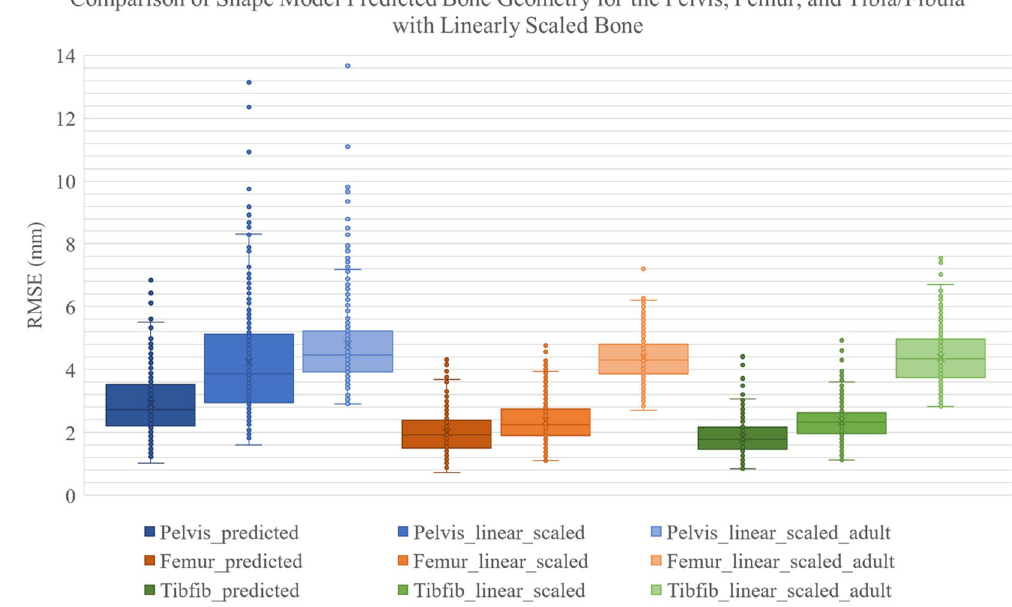
Figure 4. Results for the pelvis, femur, and tibia/fibula (tibfib) showing the RMSE (mm) for bone geometry predicted using the standard shape model (_predicted), linearly scaled geometry from the mean mesh of the shape model (_linear_scaled), and linearly scaled geometry from adult OpenSim geometry (_linear_scaled_